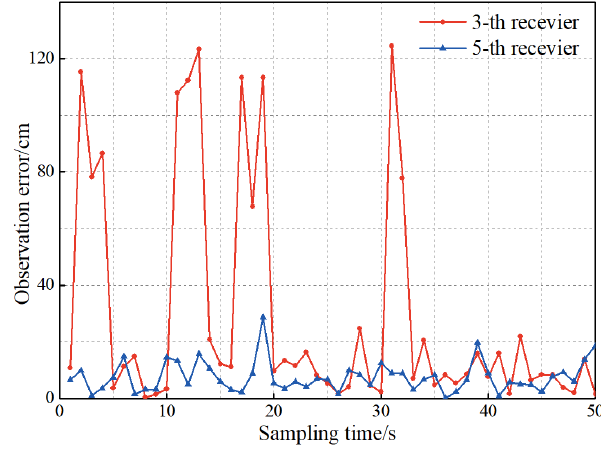
Figure 10. The observation error of the third and fifth receivers.